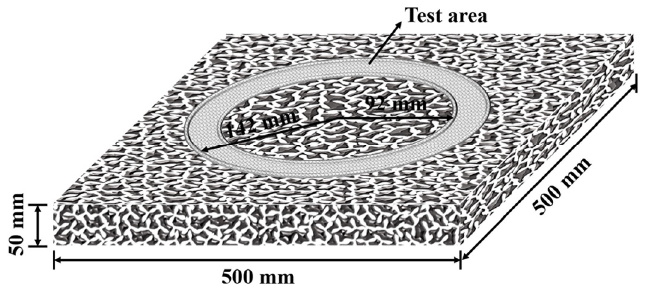
Figure 2. Schematic diagram of SSAM specimens.